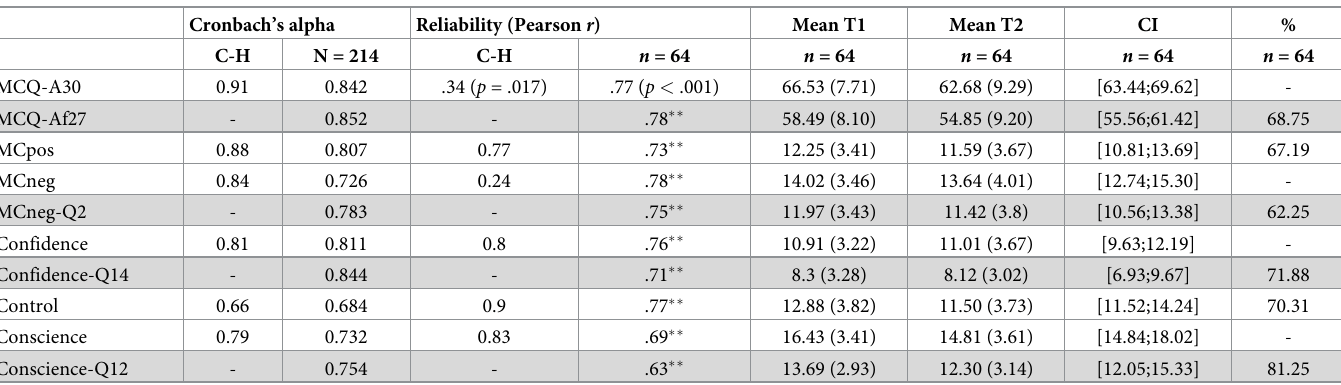
Table 3. Internal consistency and reliability of MCQ-A scores.